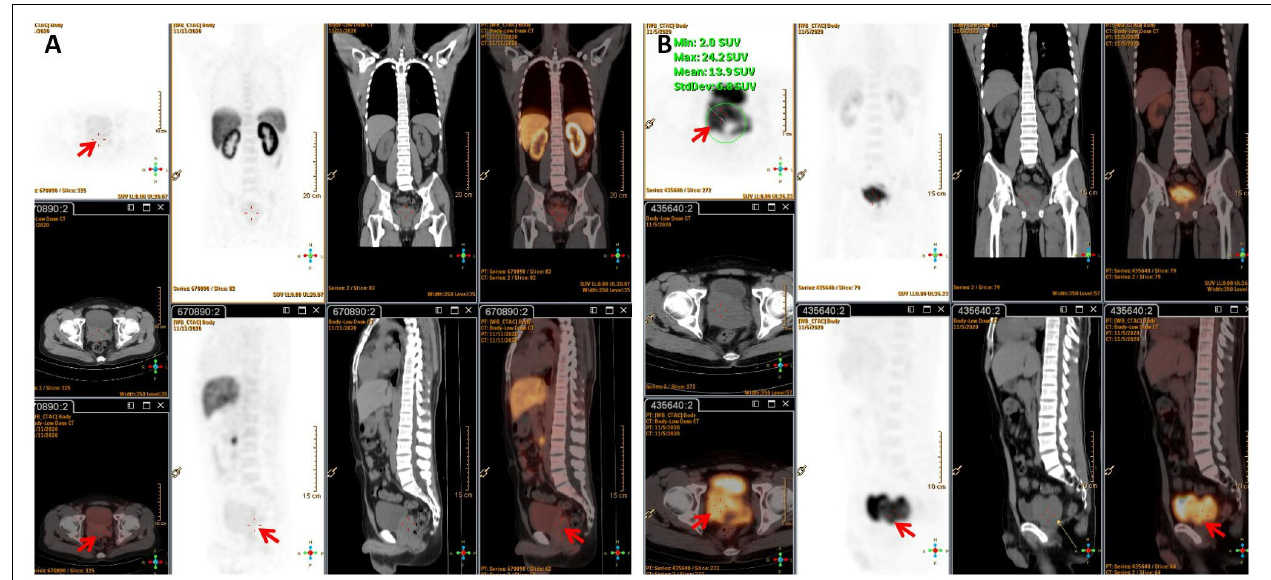
FIGURE 1 | (A) 18F-PSMA PET/CT showed no trace PSMA uptake in the lesion (red arrow). (B) 18F-FDG PET/CT revealed foci with increased glucose metabolism in the prostate and bilateral seminal vesicles. Multiple enlarged lymph nodes with varying degrees of increased glucose metabolism were observed in the hilum, retroperitoneum, and pelvic cavity.